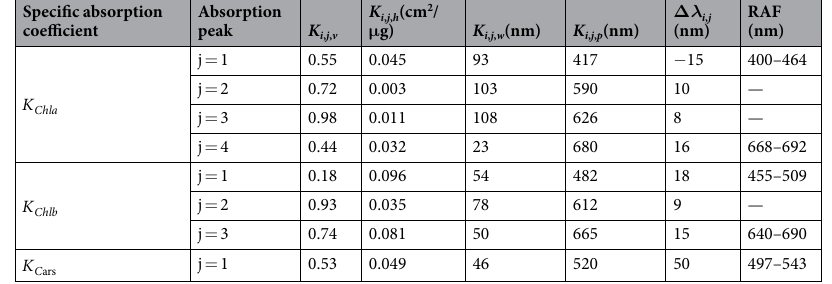
Table 1. Absorption peak characteristics determined from pigment absorption coefficients within PMP. Note that the symbol “—” stands for the negligible values in the RAFs because of the low absorbance values of these features. K , K and K are the Gauss ratio, peak height and FWHM of the j th absorption peak for the i th i j v , , i j h , , i j w , , pigment type in vivo , respectively; K is the spectral displacement of the j th absorption peak for the i th pigment type in vivo and λ ∆ K i j , ,